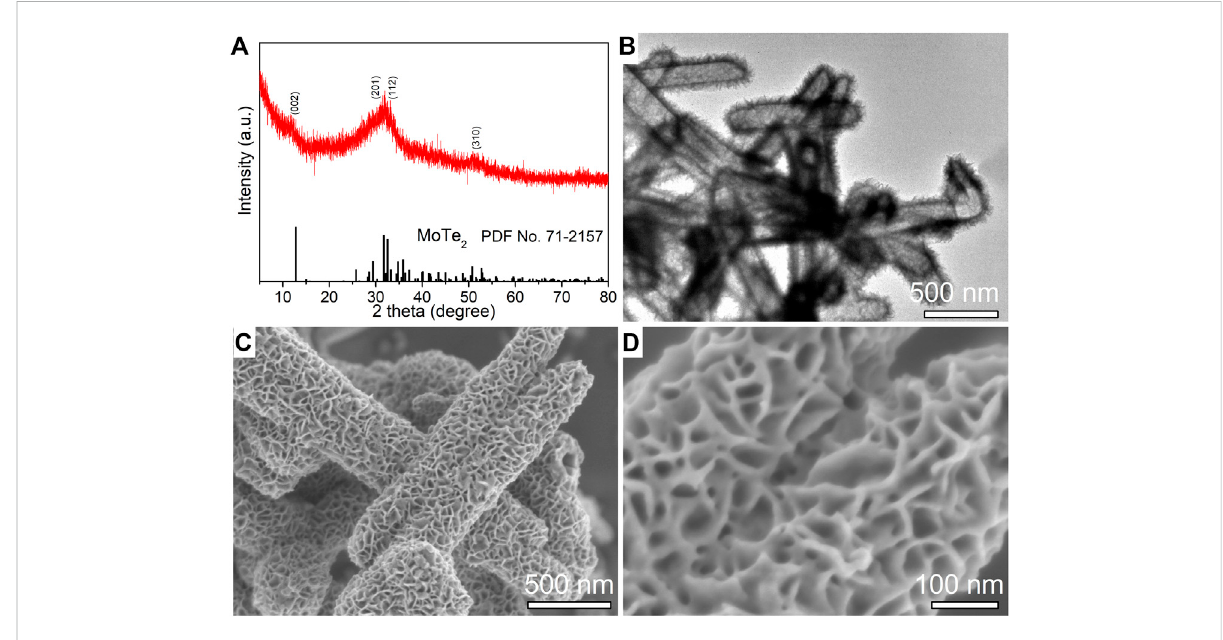
XPS. In the high-resolution Mo 3d spectrum, as illustrated